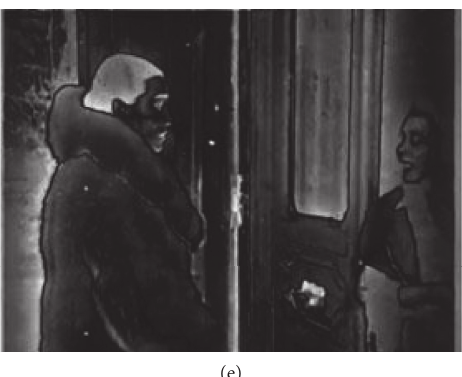
Figure 11: The saliency maps of degraded datasets: (a) “football_1,” (b) “football_2,” (c) “calendar,” (d) “yesilcam_1,” and (e) “yesilcam_2”.